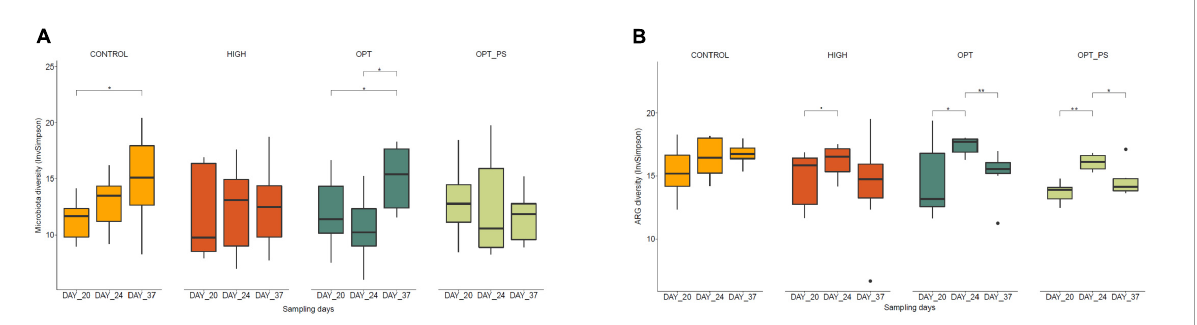
FIGURE3 Diversity analysis (based on Inverse Simpson index) of the (A) microbial taxa and (B) ARGs in chicken cecal metagenome. FDR-corrected p -value from the Mann–Whitney statistical analysis is shown. * P < 0.05, ** P < 0.01, respectively.